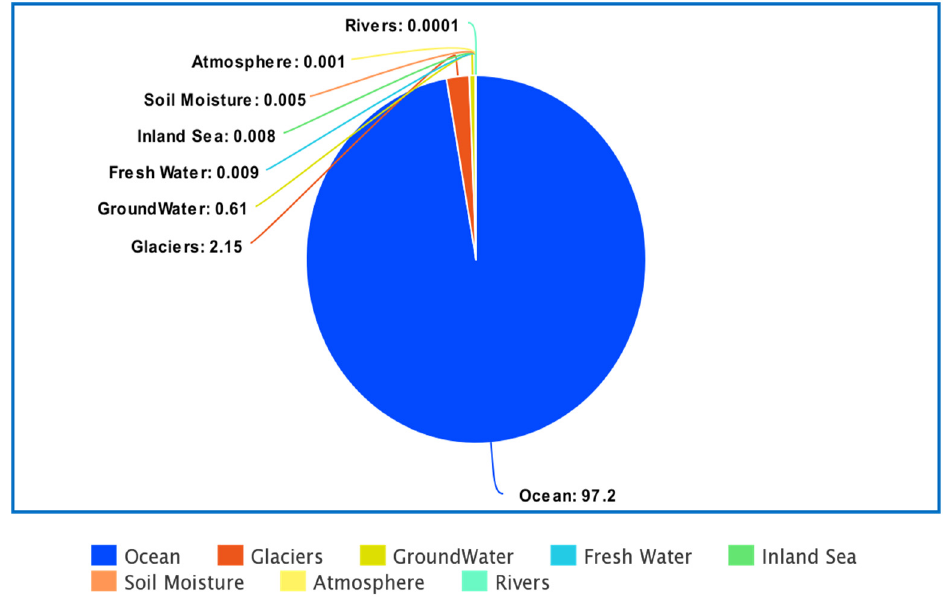
Figure 1. Distribution of earth water.